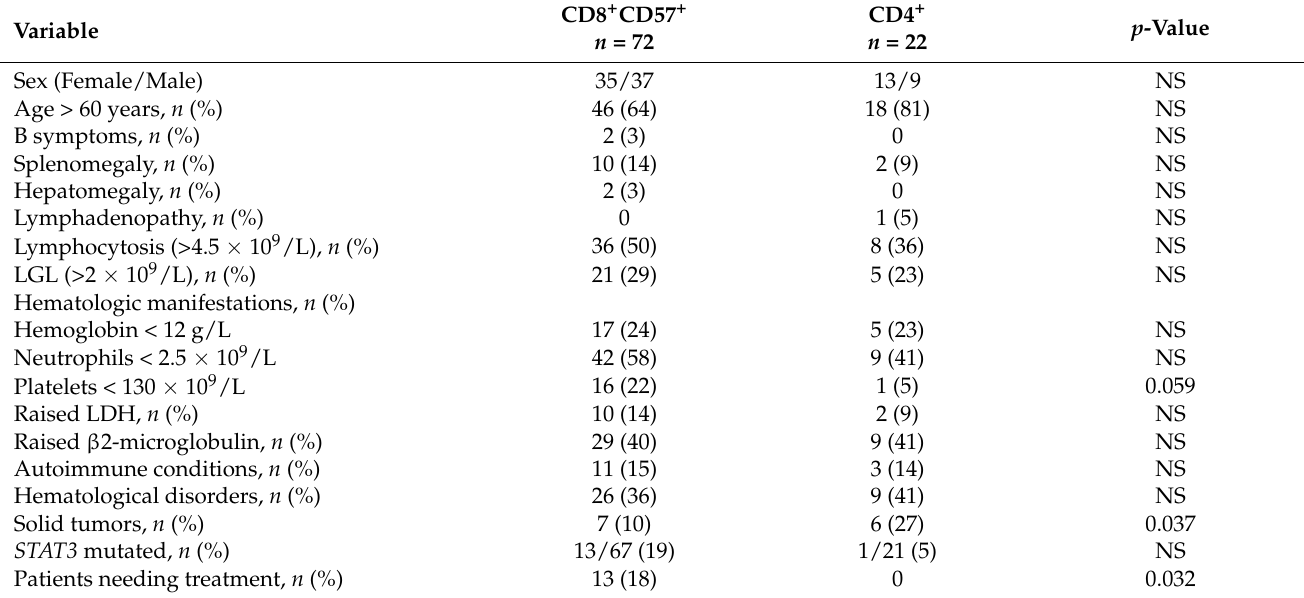
Table 3. Clinicobiological characteristics according to phenotype of T-LGLL.